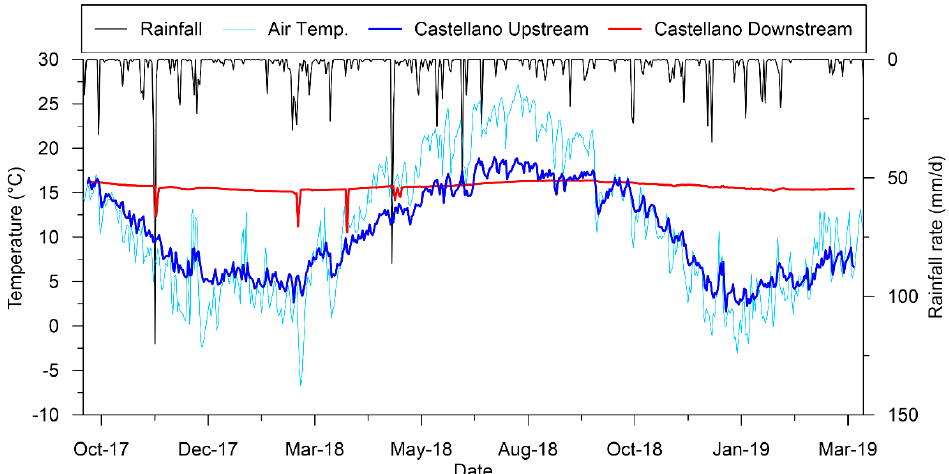
Figure 5. Continuous monitoring of the air temperature (light blue line) and of the surface water temperature in the two instrumented sections of the Castellano stretch (upstream and downstream hydrographic stations in Figure 2 are represented with blue and red lines, respectively). Rainfall for the same period is also shown (black line).